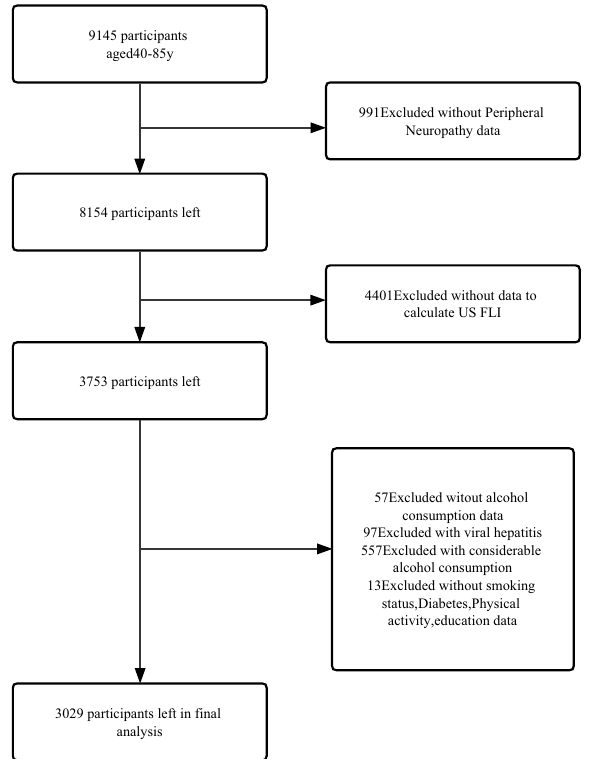
Figure 1. Flow diagram of the screening and enrollment of study